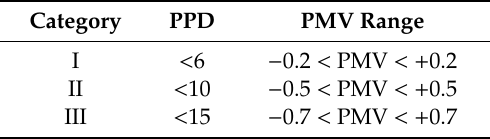
Table 2. Three categories of thermal comfort.